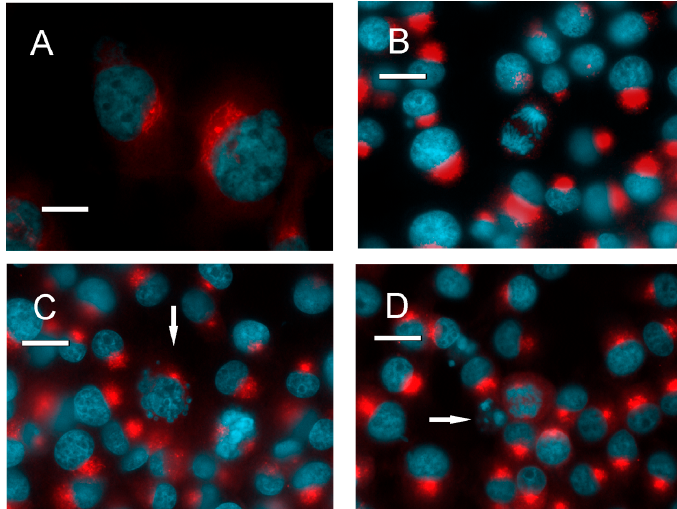
Figure 4. ( A – D ) The distribution of PKA regulatory subunit R2 changes during the cell cycle. ( A ) GLI36 cells: R2 immunoreactivity (red), bis-benzimide nuclear staining (blue). ( B ) GL261 cells during mitosis: R2 (red), bis-benzimide (blue). ( C ) GL261 cells: one apoptotic cell can be detected (arrow). ( D ) GL261 cells: one apoptotic cell can be detected (arrow). Bar = 10 μ m.